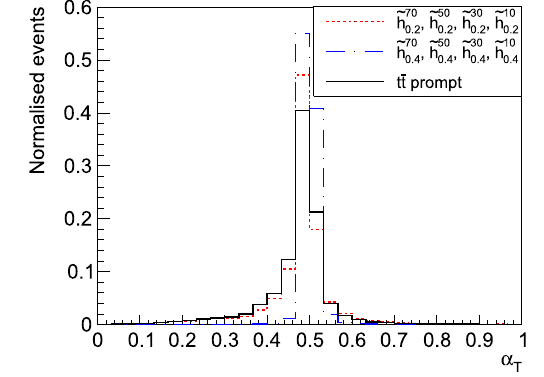
Fig. 39 α T distributions in the ˜ h 2 -like case